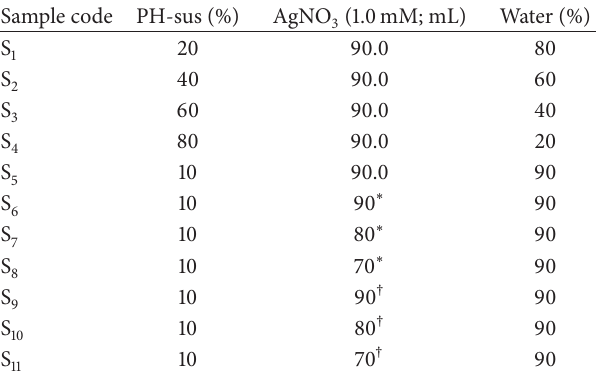
Table 1: Inputs of the reagents for the synthesis of silver nanoparti-